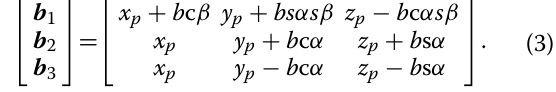
Figure 5. B i with respect to the fixed frame is given by: